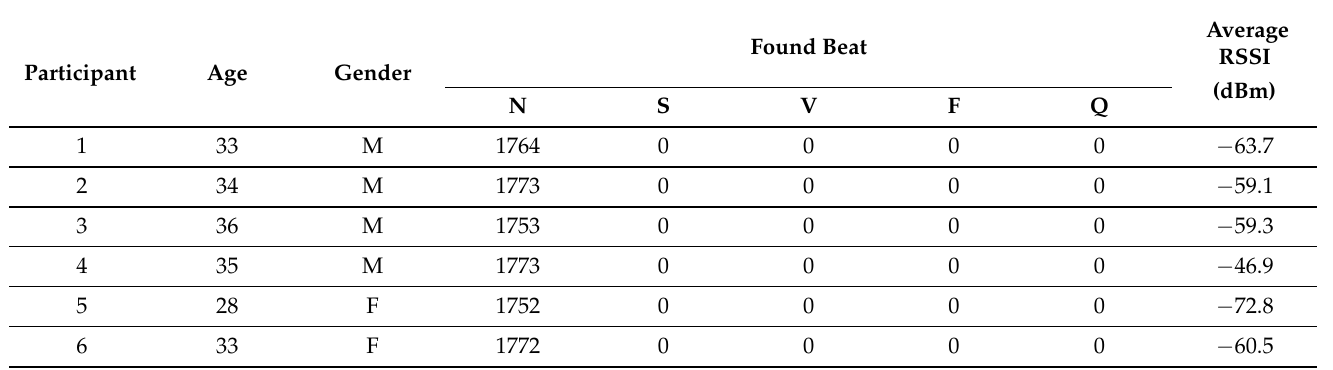
Table 19. Result the of experiment on six healthy people within 30